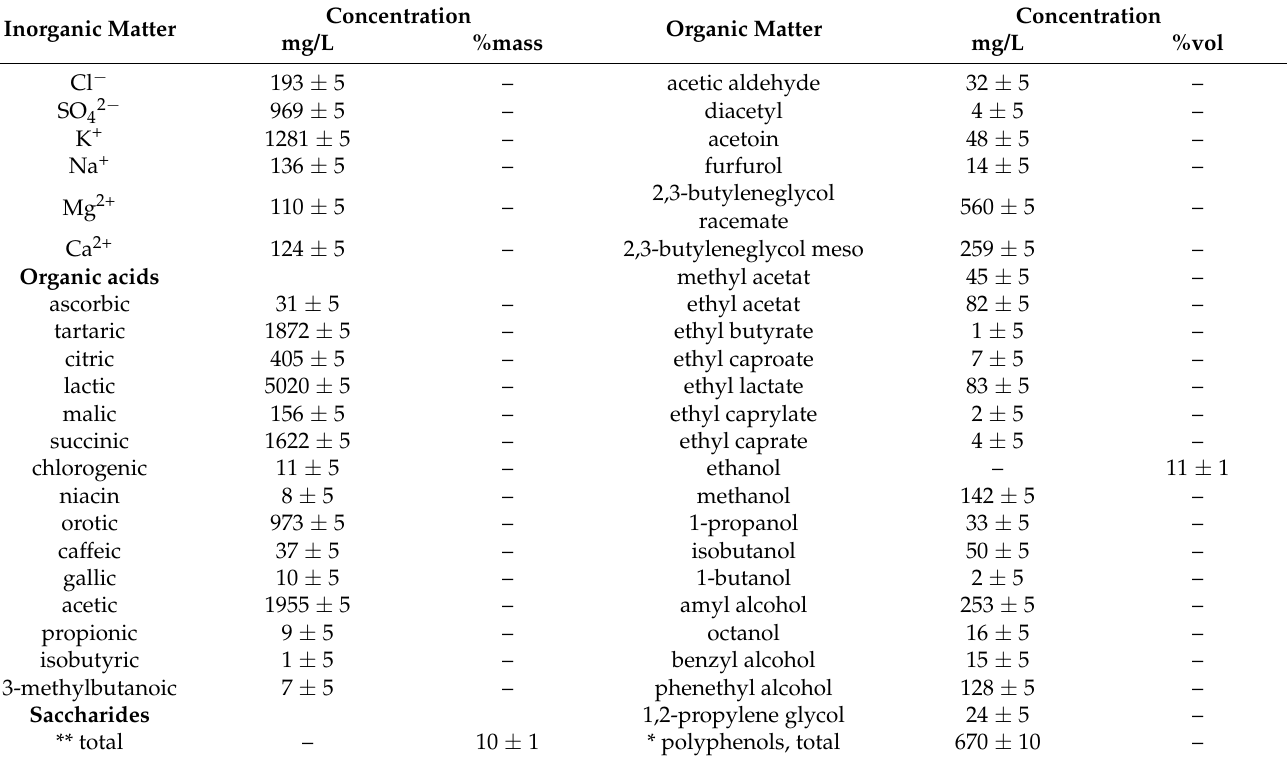
Table 2. Detailed composition of the